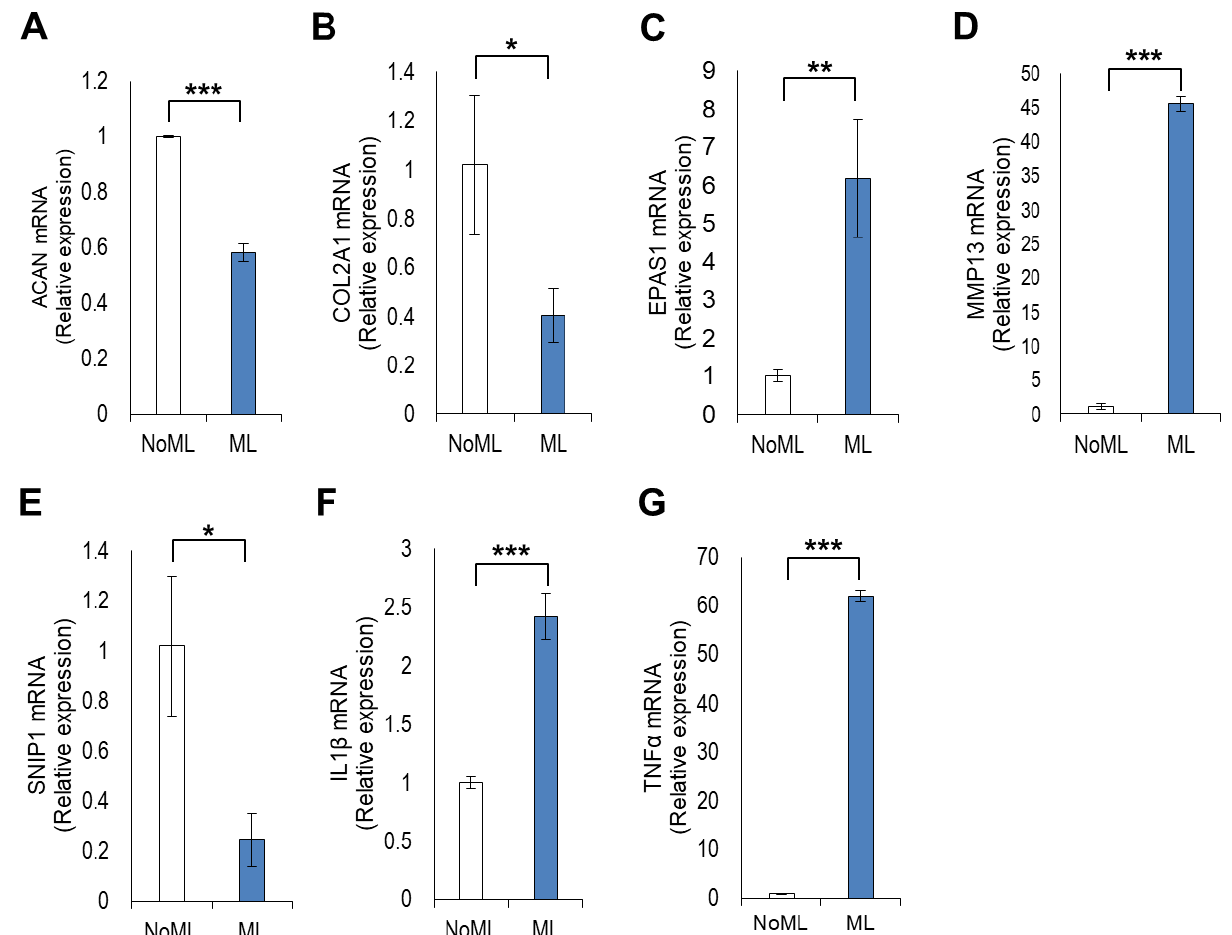
Figure 5. Gene expression analysis in cartilage tissue of mechanical loaded knee to control unloaded knee joint. Gene expression level of ( A ) ACAN, ( B ) COL2A1, ( C ) EPAS1, ( D ) MMP13, ( E ) SNIP1, ( F ) IL-1 β , and ( G ) TNF- α . Data are represented as mean ± SD. * p < 0.05, ** p < 0.01, and *** p < 0.001. ( n = 6 per group).